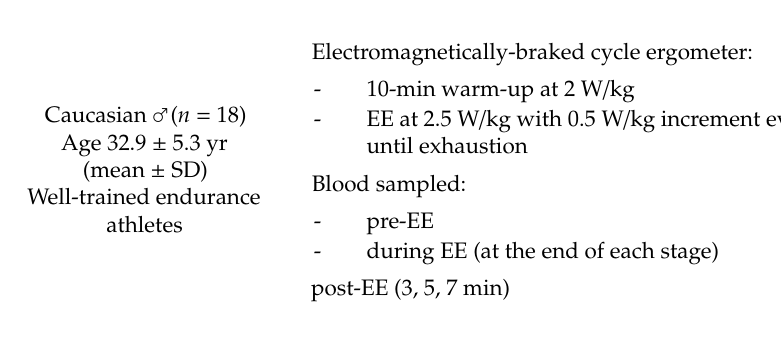
Physiological Outputs